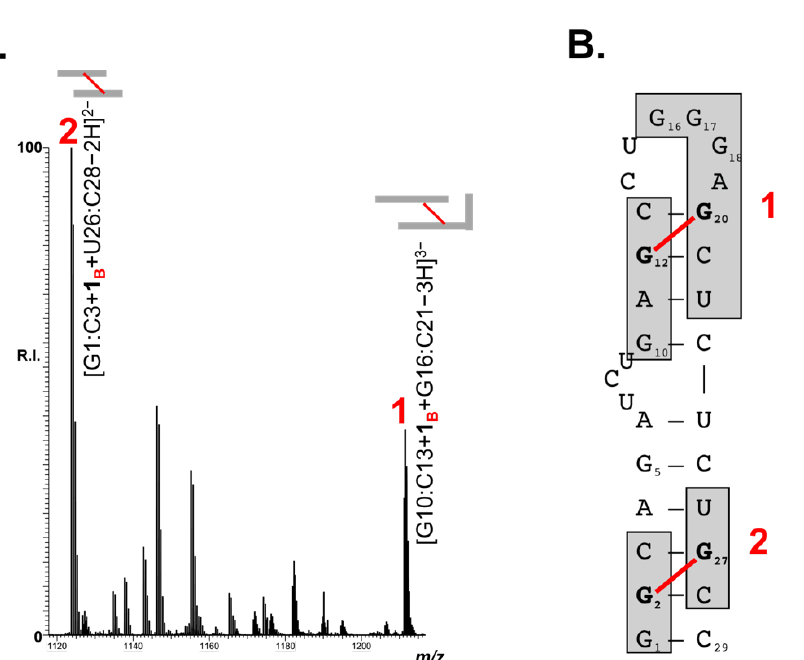
Figure 5. ( A ) Representative region of ESI-MS spectrum obtained after RNAse A digestion of TAR RNA (1 µ M) reacted with 10 µ M of B-CeP 1 . Only the most relevant bridged alkylation products, which are cross-referenced in Table 2 and highlighted in the cartoon on panel B, are indicated in the spectrum. Oligonucleotides products are indicated by the first and last base separated by colon. Product labels indicate the bi-functional alkylation products bridging base-paired regions within the TAR RNA hairpin. ( B ). Cartoon of the B-CeP 1 -induced bi-functional alkylation products bridging base-paired regions within the TAR RNA secondary structure. Table 2. Bi-functional alkylation products bridging base-paired regions within TAR RNA hairpin detected by treating TAR RNA with B-CeP 1 , followed by RNAse A digestion. Product labels refer to Figure 5. Oligonucleotides products are indicated by the first and last base, separated by colon. Product labels are also reported on the hairpin secondary structure cartoon in Figure 5B.